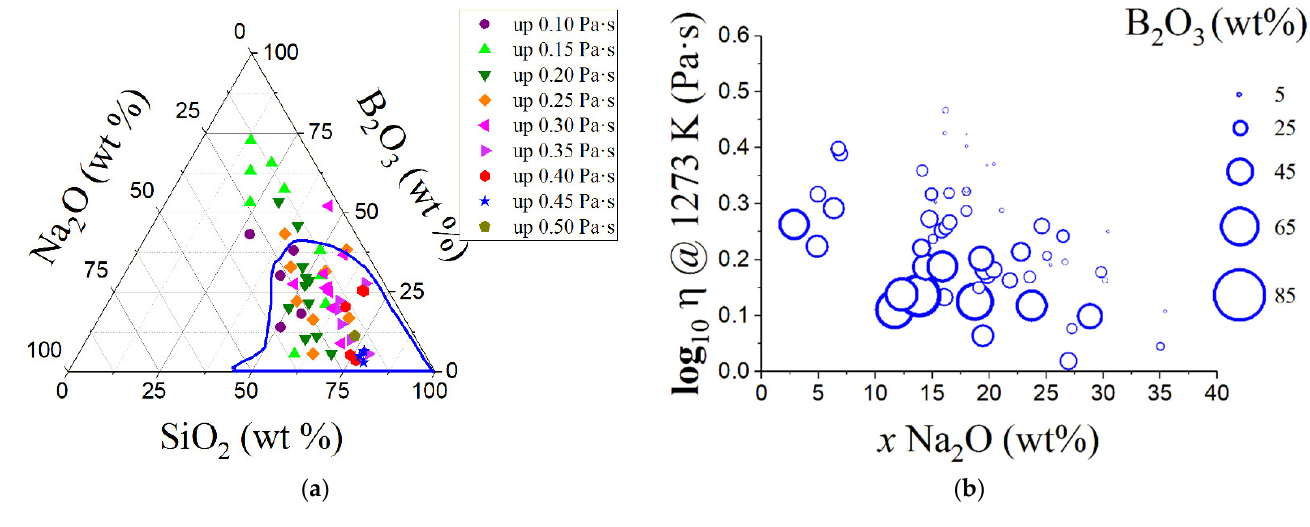
Figure 11. ( a ) Ternary diagram of selected sodium borosilicate glasses from Sciglass TM database (version 7.9). The blue region corresponds to approximately the logarithmic behavior of viscosity from a plethora of sodium borosilicate waste-immobilization glasses. ( b ) The dependence of the logarithm of viscosity at 1273 K on sodium oxide content. The logarithm of viscosity at a fixed temperature of 1273 K decreases with the sodium oxide content. In general, the viscosity increases with a decrease in boron oxide content for a fixed sodium oxide content.